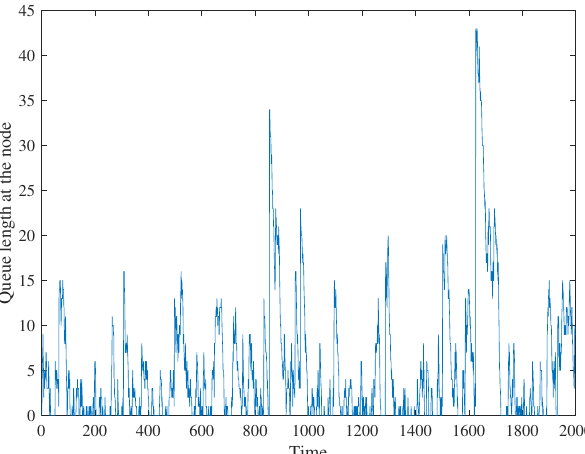
Figure 6. Queue length at one